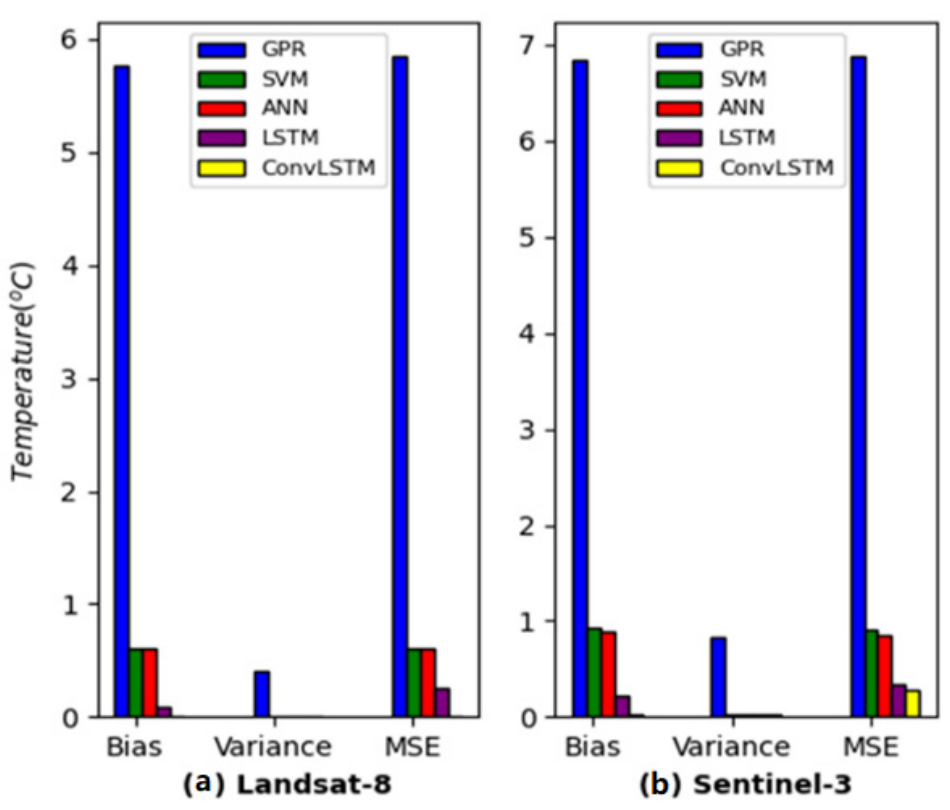
Figure 11. Bias-Variance Trade-offs and MSE bar charts for all the models: ( a ) L8, and ( b ) S3